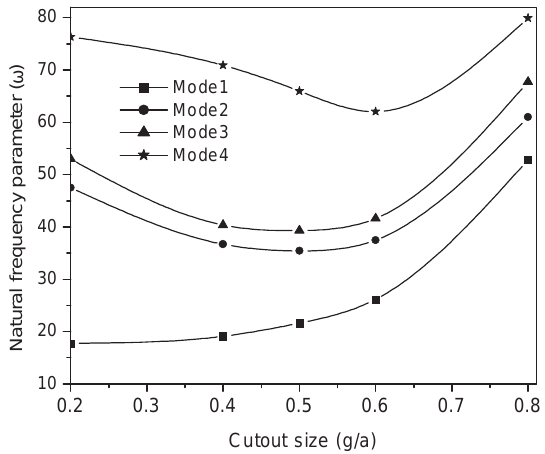
Fig. 10. Frequency parameters for a simply supported stiffened squareplatehavingonecentralstiffenerwithsquarecutoutssubjected to uni-axial compressive forces.